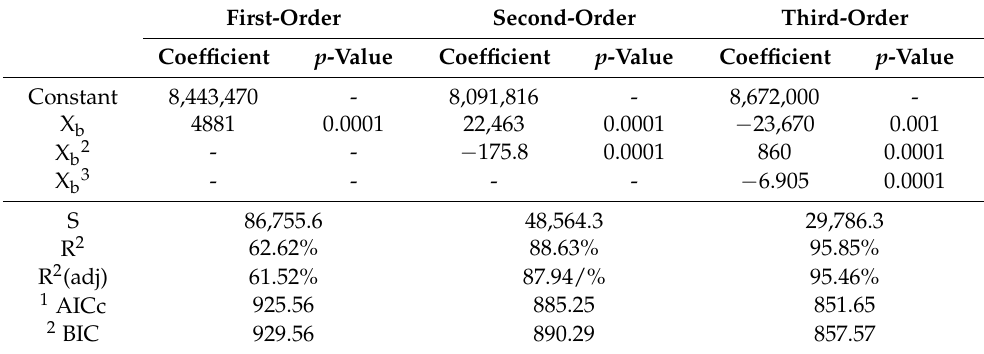
Table 4. Stepwise regression analysis along with coefficients of each equation and model